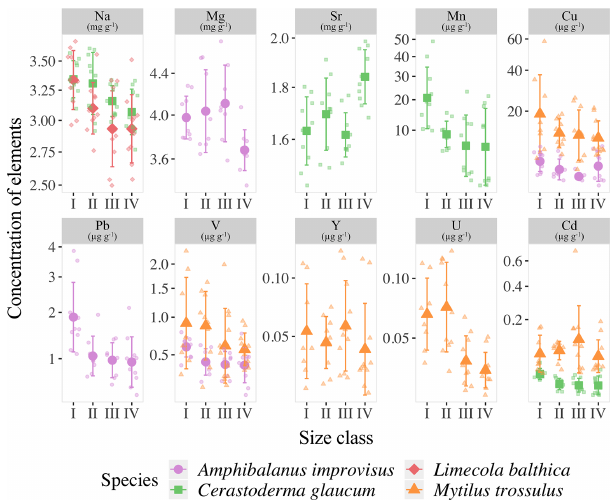
Figure 4. Mean concentrations of elements with statistically signif- icant differences between the four size classes (for size class details see Table 2) in the shells of studies species; error bars indicate stan- dard deviations ( ± 1SD). Concentrations of Mn, Cu, Pb, Cd, V and Y are presented using a square root